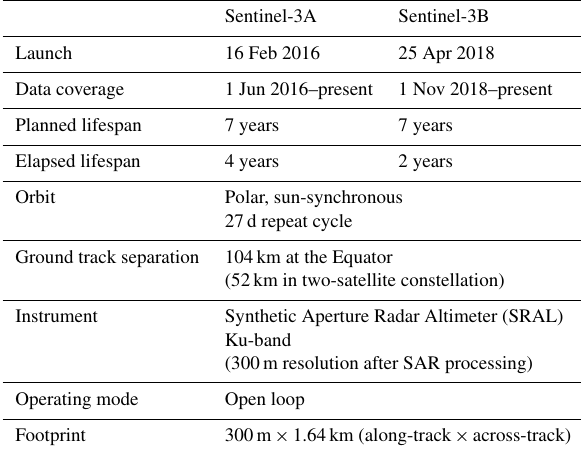
Table 2. Sentinel-3 mission